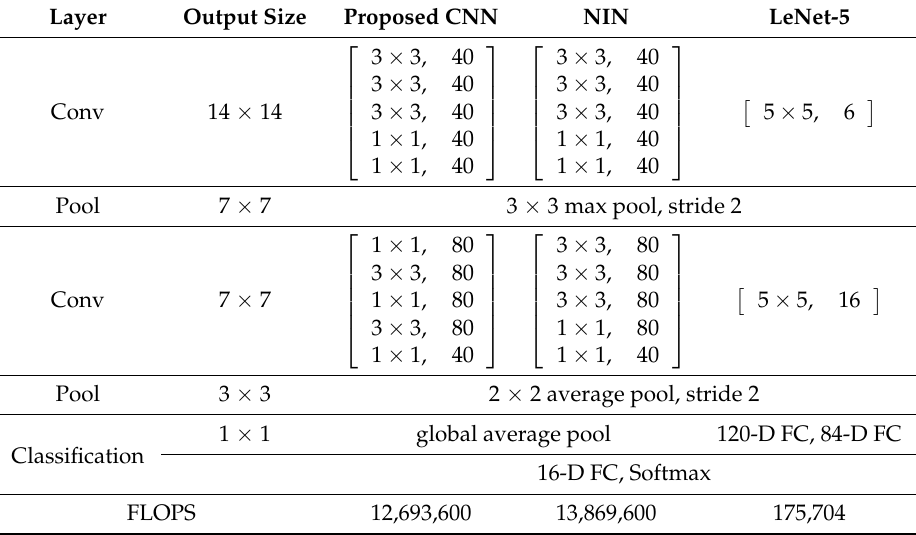
Table 8. The architecture of proposed CNN/NIN/LeNet-5.